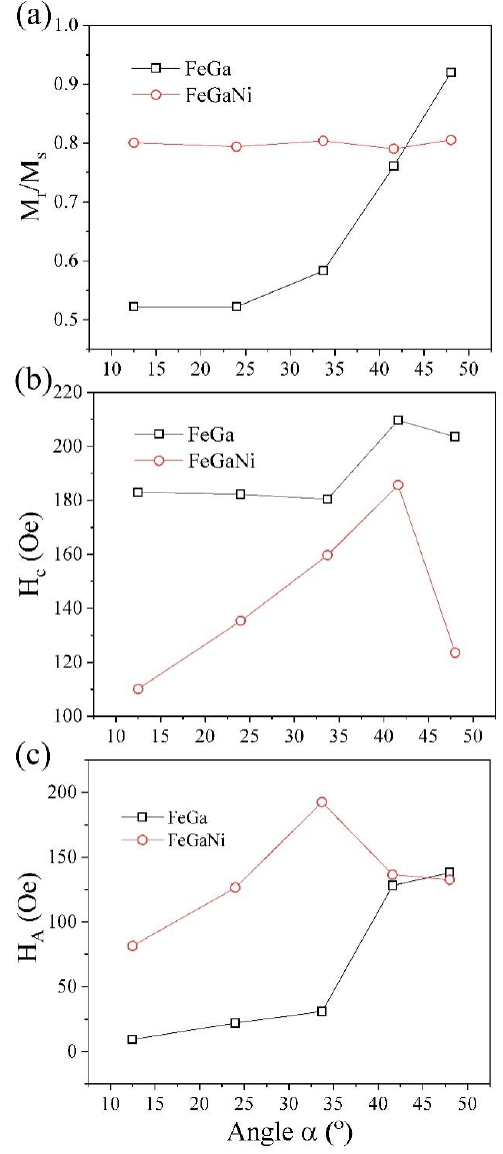
Figure 5. Mr/Ms ( a ), Hc ( b ), and HA ( c ) of FeGa and FeGaNi with increase in α .